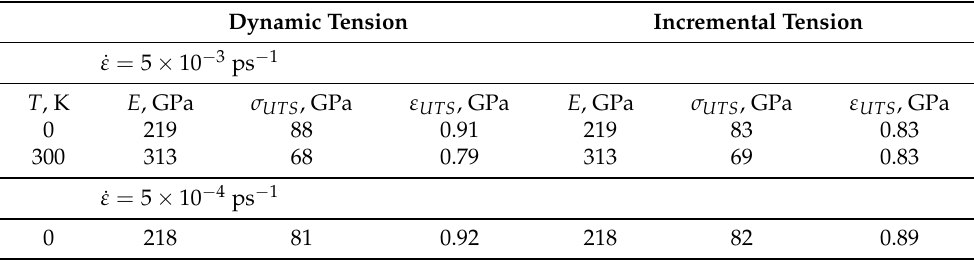
Figure 3. ( a ) Stress–strain curves during uniaxial dynamic tension for Ni/graphene composite at two stress rates: ˙ ε = 5 × 10 − 3 ps − 1 and ˙ ε = 5 × 10 − 4 ps − 1 . ( b , c ) Snapshots of Ni/graphene composite. Colors as in Figure 1. Table 1. Numerical characteristics of the mechanical properties of Ni/graphene composites: ultimate tensile strength σ UTS and ultimate tensile strain ε UTS , Young’s modulus E